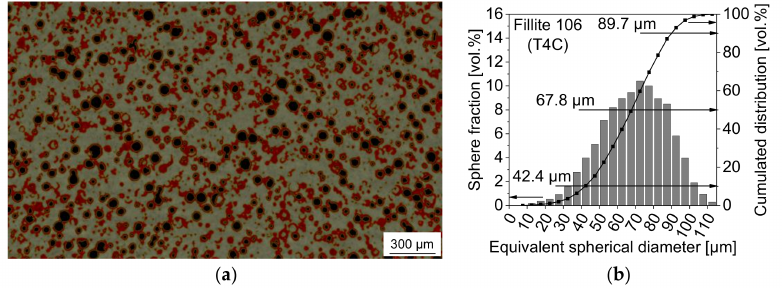
Figure 2. Tomographic imaging of the syntactic TRIP steel matrix foam with 40 vol % Fillite 106: ( a ) reconstructed 2D image (pale grey—matrix, cenospheres: red—solid part, black—cavities/pores); ( b ) sphere size distribution (using equivalent spherical diameter, ESD).